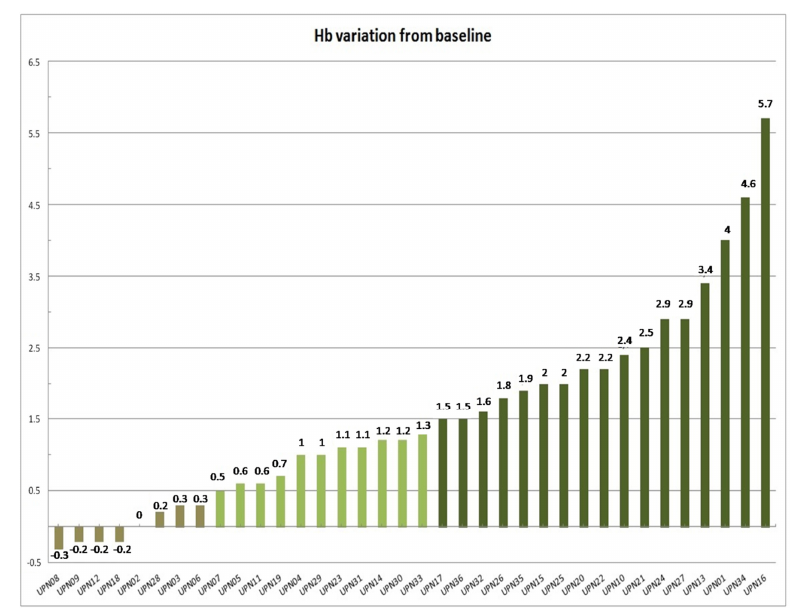
Figure 1. Waterfall plot indicating the Hb variation at 8th week from treatment start. Dark green indicates patients responding (Hb greater than 1.5 g/dL) at this time. Light green indicates patients who showed a Hb increase of at least 0.5 g/dL (but less than 1.5 g/dL). Brownish green indicates patients who showed Hb reduction or less than a 0.5 g/dL raise. At week 16, 17 refractory patients were evaluable (1 patient was lost-to-follow-up). Eight patients proceeded with the same dosage (Figure 2A), and four patients (50%) re- sponded, while four patients (50%) remained refractory to the ESA. Nine patients (53%)